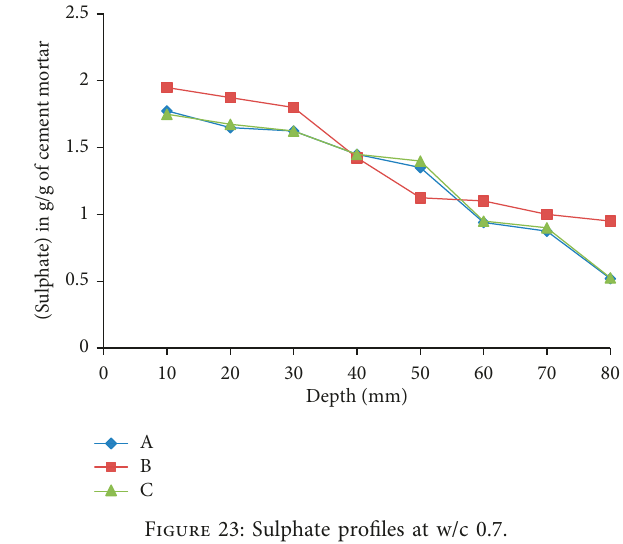
Figure 23: Sulphate profiles at w/c 0.7.